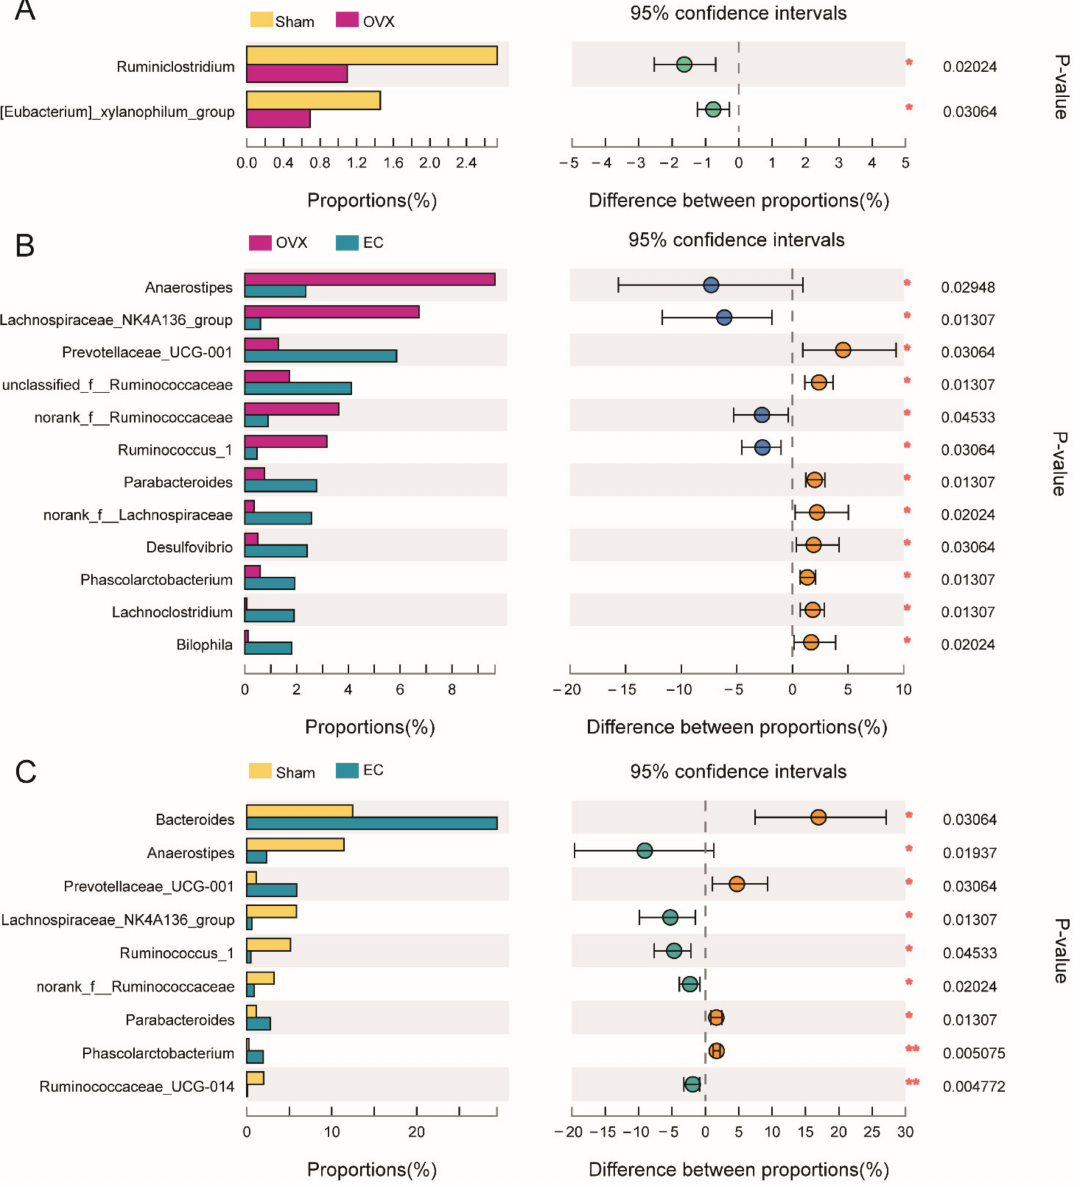
Figure 5. Extended error bar plot identifying the significant differences of phylotypes between mean proportions of top 20 bacterial taxa at genus level. ( A ) Sham vs. OVX; ( B ) OVX vs. EC; ( C ) Sham vs. OVX. Data were showed as relative abundance (%). n = 6 in each group. Statistical analysis was performed by the Wilcoxon rank-sum test, and * p < 0.05, ** p <